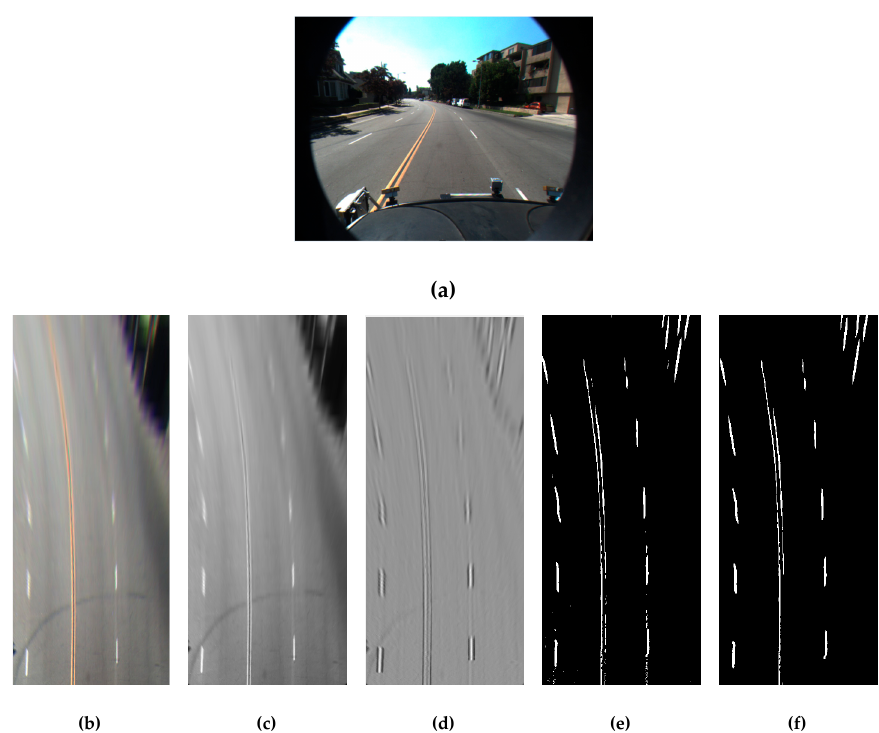
Figure 5. Ridge-feature extraction illustration. ( a ) Original map I . ( b ) Aerial view map I a . ( c ) Gray map. ( d ) Ridge map I r . ( e ) Ridge binary map I b . ( f ) Map when areas with pixel numbers less than 30 are removed.